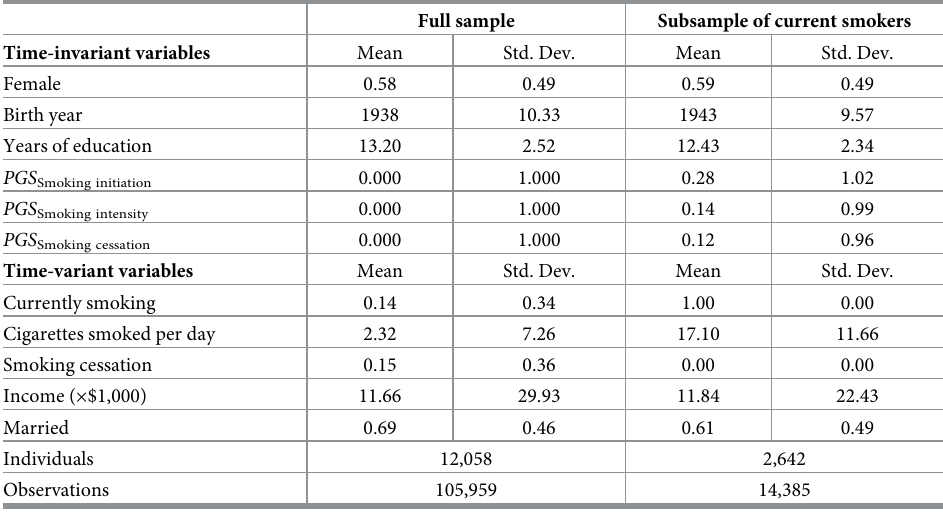
Table 1. Descriptive statistics analysis